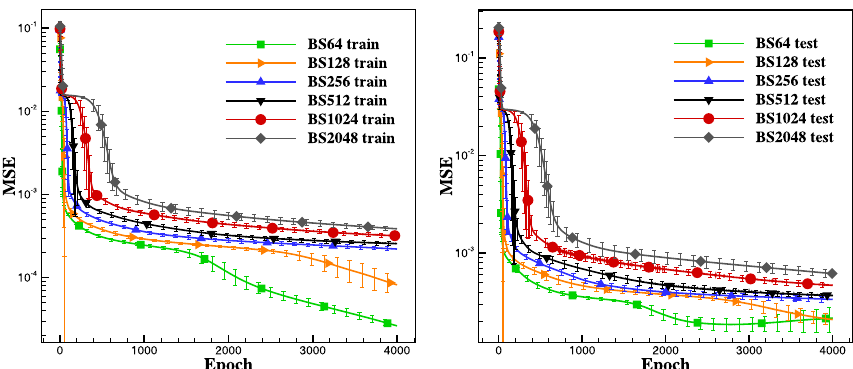
Fig. 18 MSE convergence histories of CNN‑2 with different batch sizes in training dataset (left) and test dataset